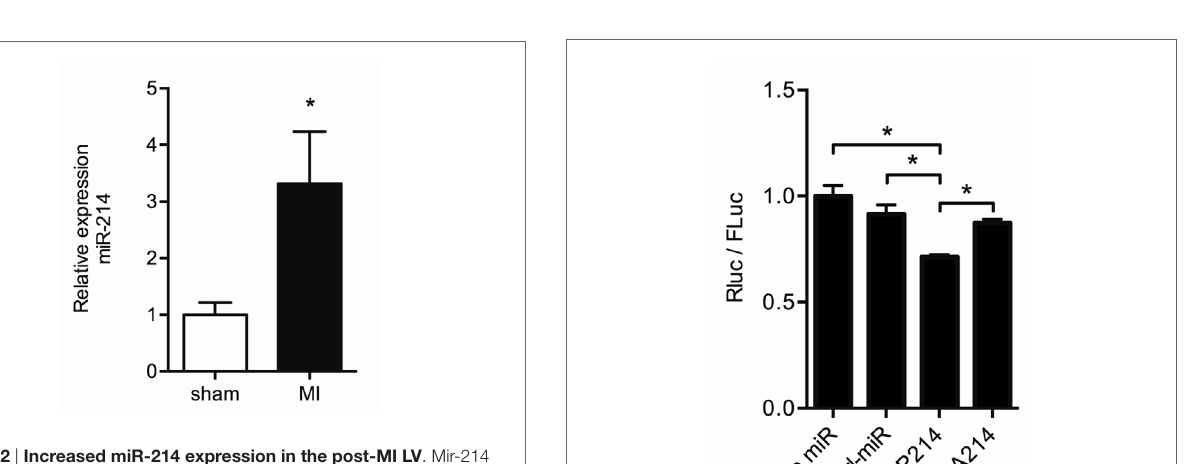
FigUre 1 | conserved mir-214 target site in the 3 ′ -UTr of Dio3 . In silico analysis predicts a target sequence for miR-214 in the stem of SECIS element of the 3 ′ UTR of Dio3 in mice, which is highly conserved among species. (Source: Targetscan and microRNA.org).